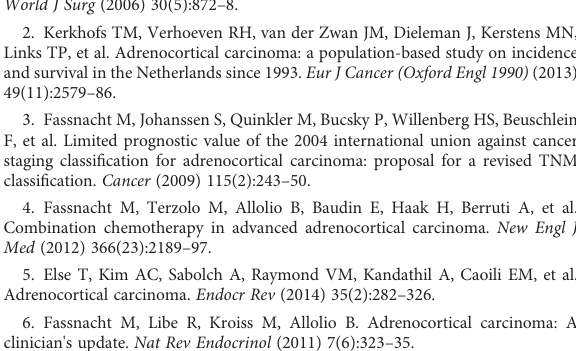
SUPPLEMENTARY FIGURE Differential genes and functional enrichment between GR-low and GR- high subgroups. (A) Volcano plots and (B) hierarchical clustering analysis ofmRNAsthatweredifferentiallyexpressedbetweenGR-hightumorsand GR-low tumors. (C) KEGG pathway enrichment analysis and (D) GO enrichment analysis of genes upregulated in the GR-low subgroup and genes upregulated in the GR-high